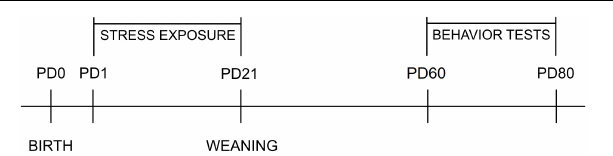
FIGURE 2 | The timetable of experiments. PD, postnatal